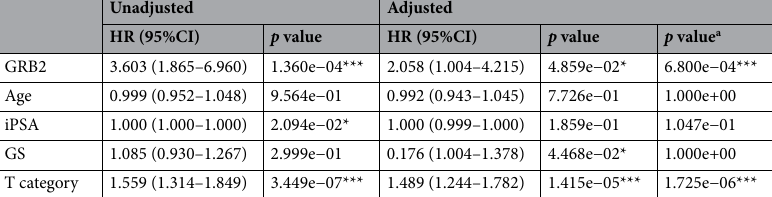
Table 6. Multivariate analysis of effect of GRB2 expression on survival (based on data from clinical samples). GRB2 cut off, z-score ≥ 1; iPSA: initial PSA: GS: Gleason score; “*” and “***” indicate p value < 0.05 and < 0.001, respectively. a Adjusted p value (using a Bonferroni